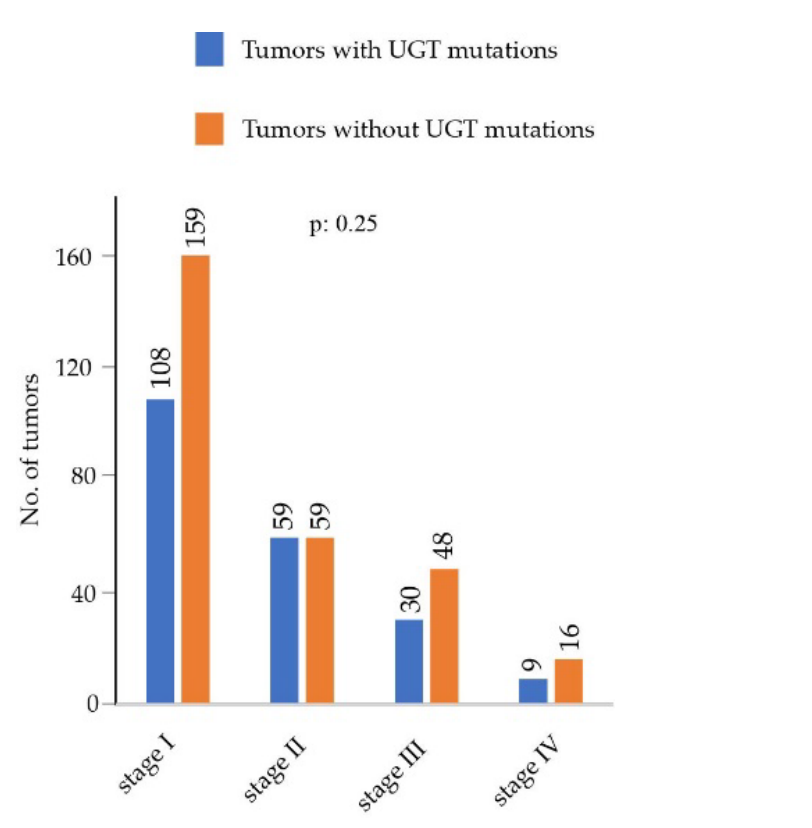
Figure 8. Assessment of potential associations of UGT mutations with tumor stages in the LUAD cohort. A graph shows the numbers of tumors at four different tumor stages in the LUAD cohort. Chi-squared tests. A p value of < 0.05 was considered statistically significant.